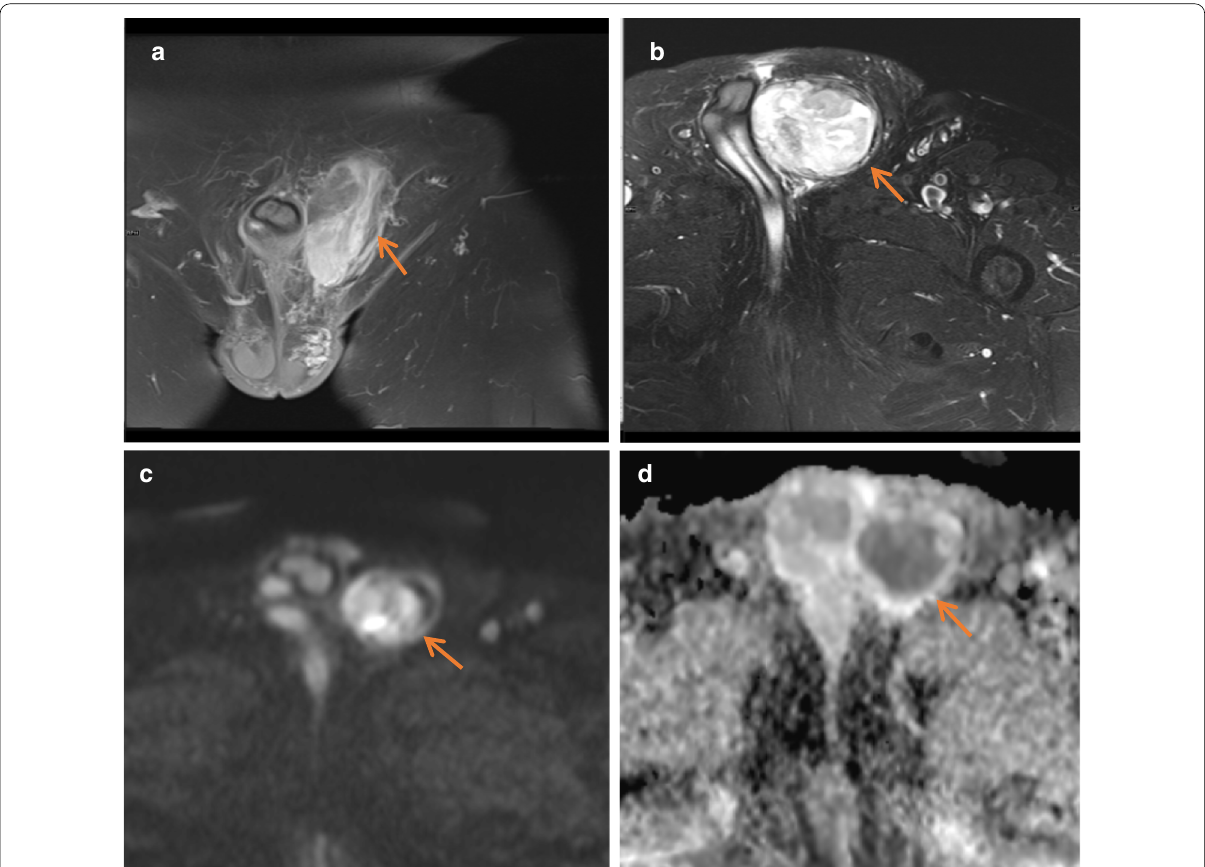
Fig. 17 UPS of the spermatic cord a Coronal T1 fat sat post-contrast and b axial T2 fat sat images show a large heterogeneously enhancing high T1 and T2 signal mass within the left inguinal canal and scrotum (red arrow). c Axial DWI and d ADC images demonstrate a predominantly solid mass with restricted diffusion in keeping with necrosis or cystic change